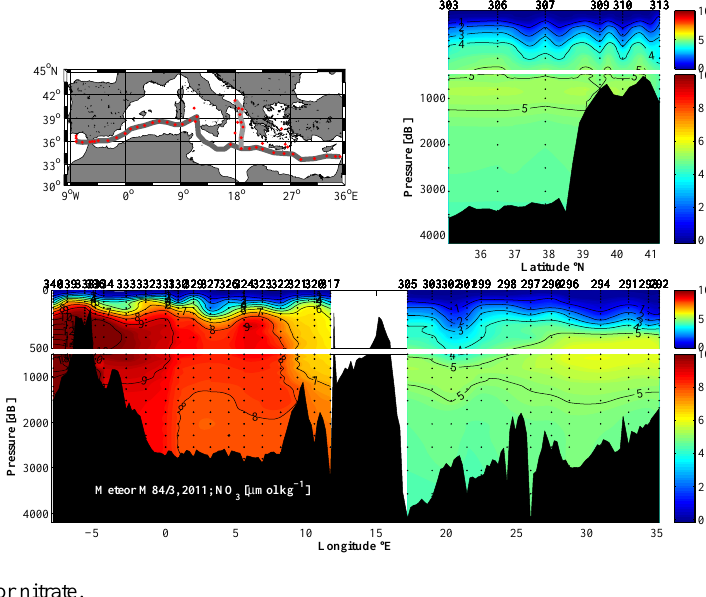
Fig. 7. Similar to Fig. 3, but for nitrate.